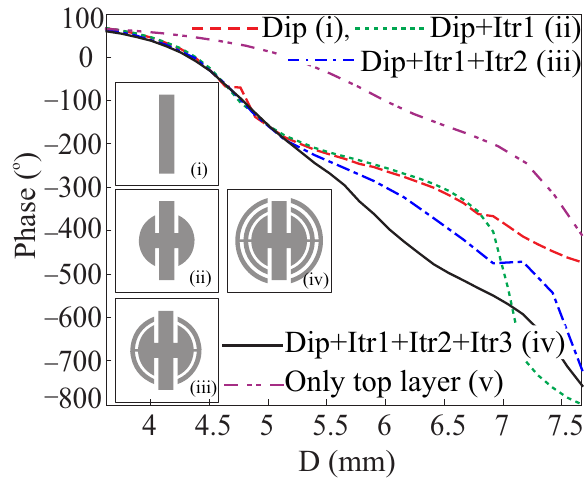
Figure 3. Step-by-step evaluation of the unit cell. Furthermore, checking the unit cell performance over the bandwidth, the normalized reflection phase curves for different frequencies are depicted in Figure 4. The phase curves are linear and insensitive to the frequency variation when D varies from 4.2 mm to 7 mm, which anticipates the broadband behavior of the unit cell. The effect of the various incident wave angles on the reflected phase performance is given in Figure 5, which shows a negligible phase variation with the angle of incidence. It is important to show the current distribution on the unit cell as it accounts for the low x-pol level. Figure 6a,b shows the current distribution on the top and middle layer of the unit cell at 11.725 GHz for the case when the dipole and iterations are not shorted with each other. The top-layer currents on the first and third iterations are symmetrical, which results in a complete single polarized net current. However, the dipole and second iteration carry asymmetrical currents that cause an increase in the x-pol level. Similarly, the currents on the concave arms in the middle layer are mirror images of each other, whereas the circular ring has a net counterclockwise current. In the figure, I y and I x represent the desired co-pol and x-pol currents on the unit cell. To avoid the x-pol current, the dipoles and iterations are shorted with each other, as shown in the proposed design. The current distributions are shown in Figure 6c,d on the top and middle layer of the unit cell, respectively. The net current on the top and middle layers exist only along the length of the dipole, whereas the components of all the currents that are orthogonal to the length of the dipole cancel each other out. Therefore, good performance can be anticipated in terms of the x-pol level.